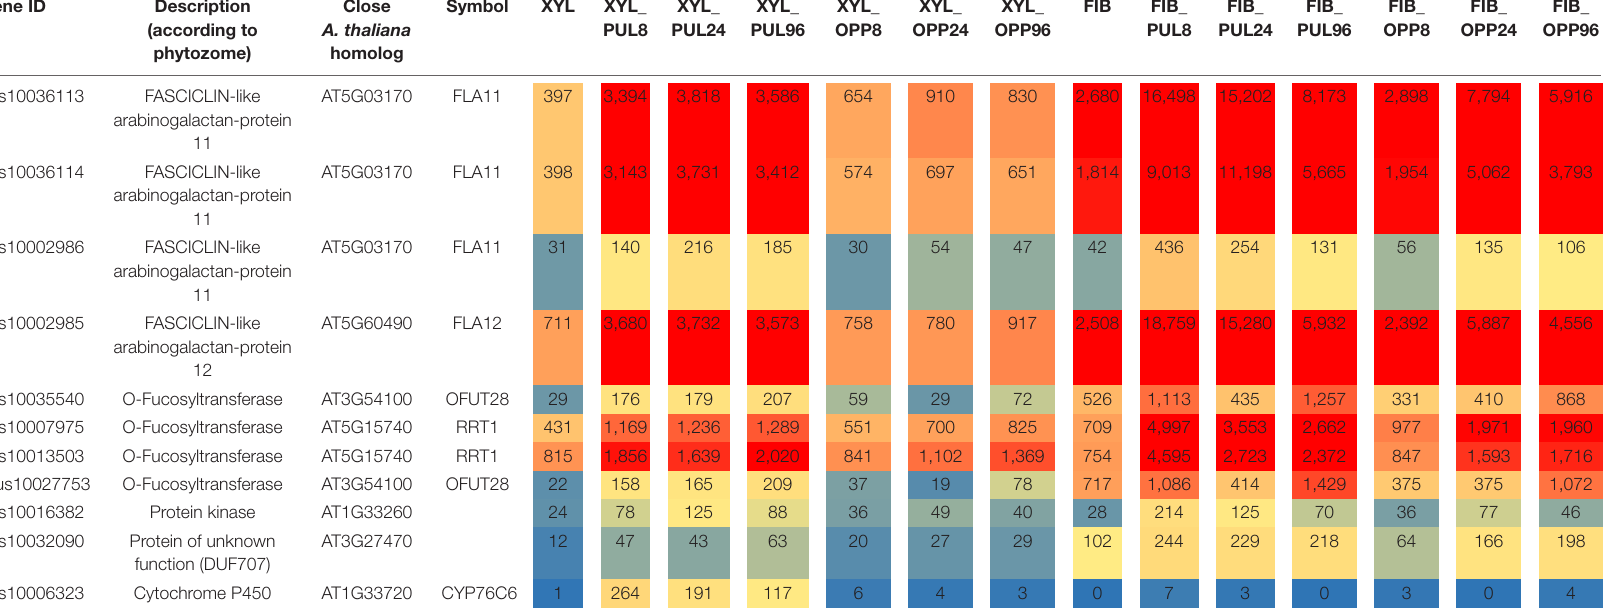
TABLE 1 | Flax genes continuously upregulated (fold change ≥ 2, p adjusted < 0.01) in the pulling-side xylem but not in the opposite side of inclined plants in the comparison with control xylem. Gene